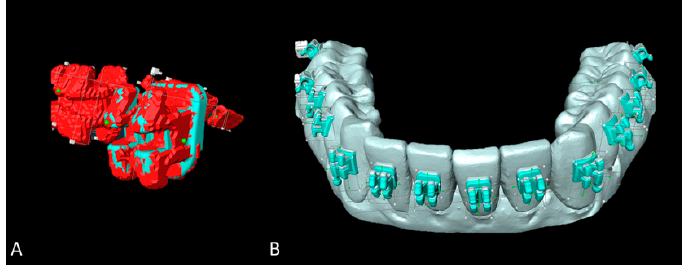
Figure 5. Superimposition and image post-processing with Amira software. ( A ) Micro-CT scanned brackets (red) and the superimposed original brackets (green). ( B ) Reference study models (SMref) visualized in grey and corrected brackets from micro-CT scanned study models (SMtest-mCT) visualized in turquoise.